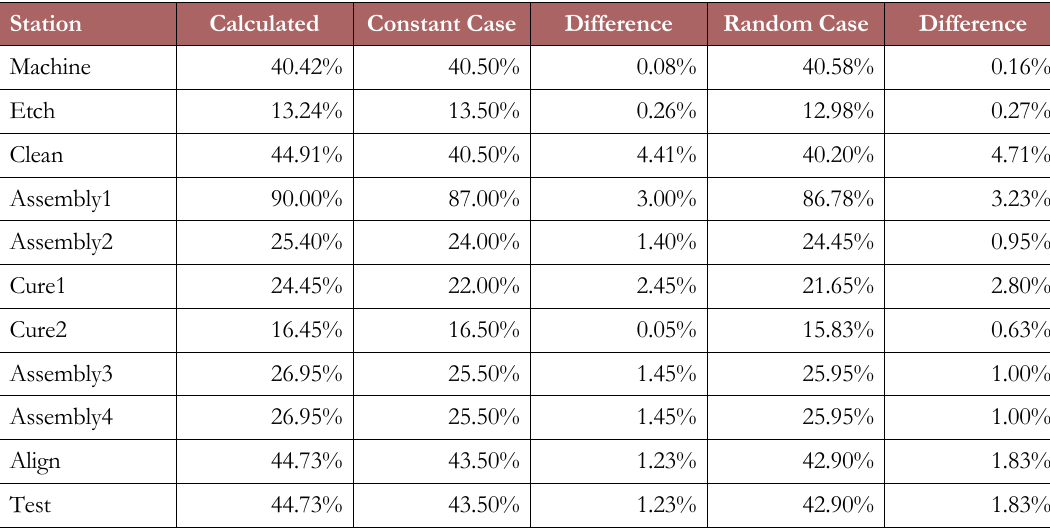
Table 6. Individual Resource Utilization Comparison and Validation For CONWIP model